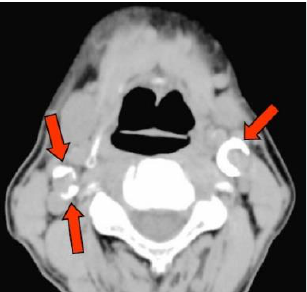
Figure 1. Observation of the carotid artery calcification. Arrow tip indicates the calcification.